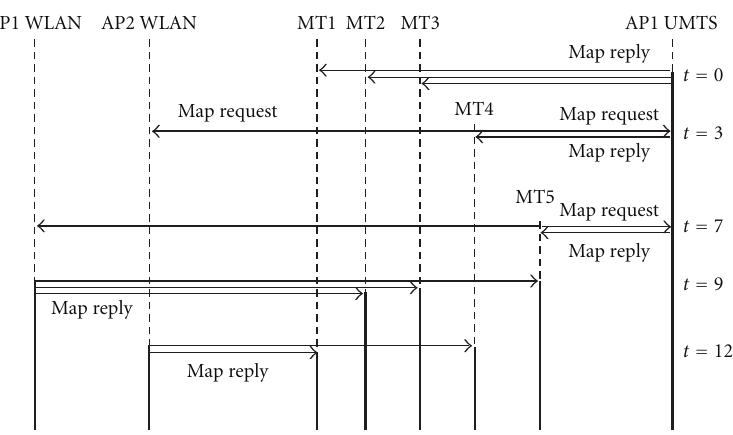
Figure 2: DAMB procedure in a mesh network example